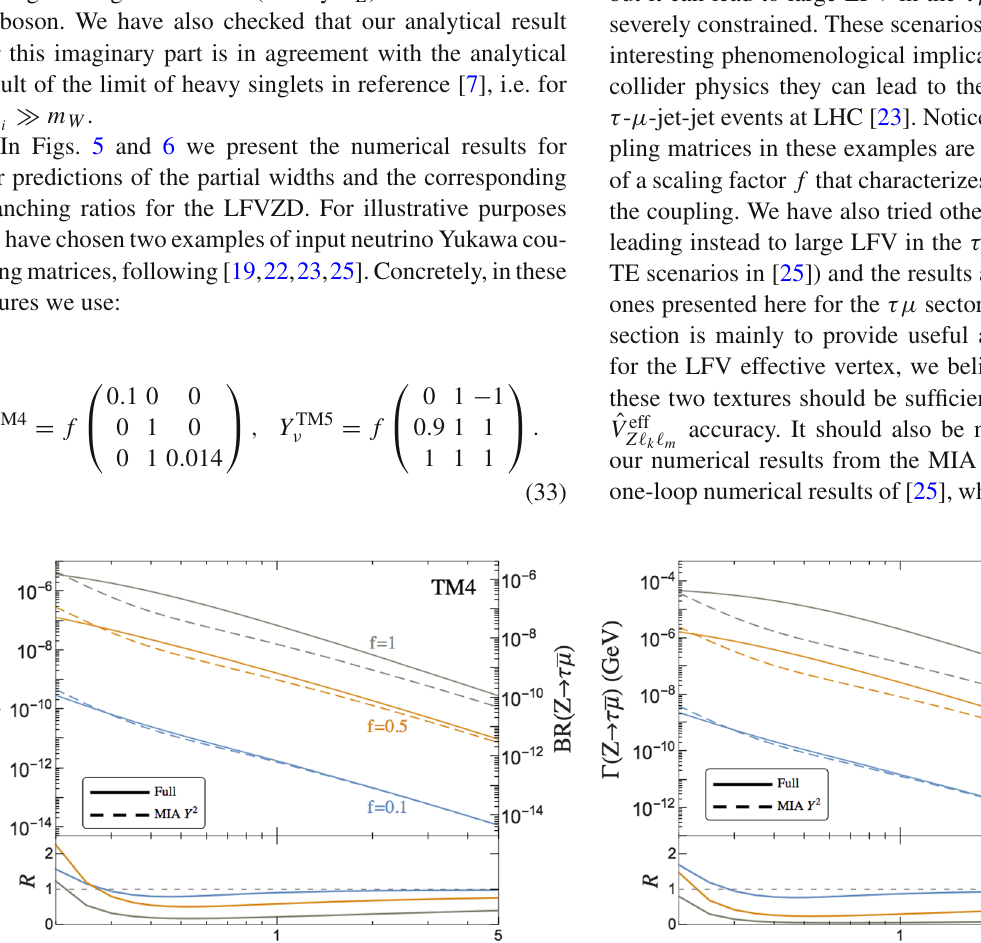
ples TM4 (left panel) and TM5 (right panel) with f = 0 . 1 , 0 . 5 , 1, as explained in the text, are chosen. In the bottom of these plots the ratio R = (cid:5) MIA /(cid:5) full is also